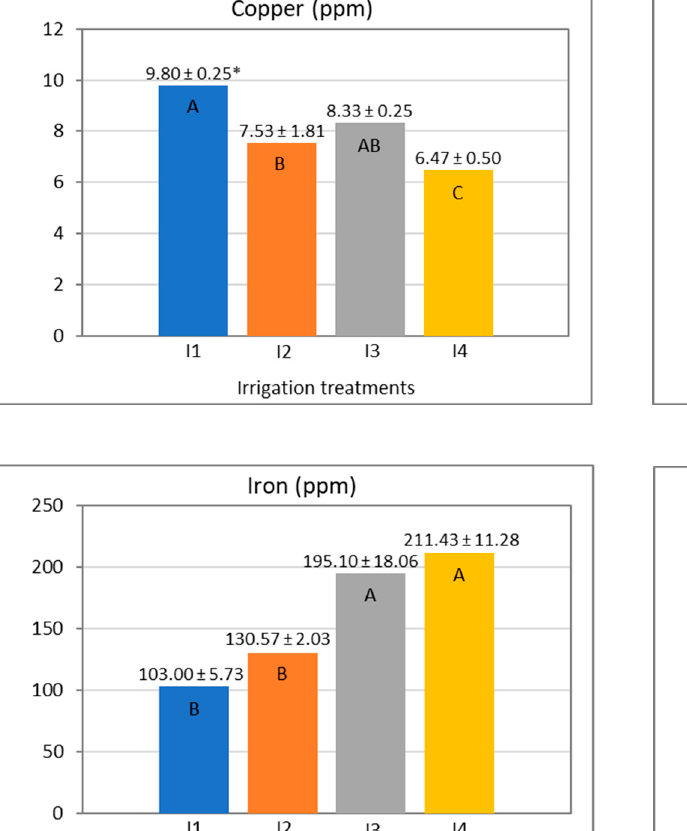
Figure 3. Concentrations of Cu, Mn, Fe and Zn in tomato leaves cultivated under different irrigation conditions; * mean ± standard deviation; data in bars with the same letters are not significantly dif- ferent at p > 0.05 according to Tukey’s Test.